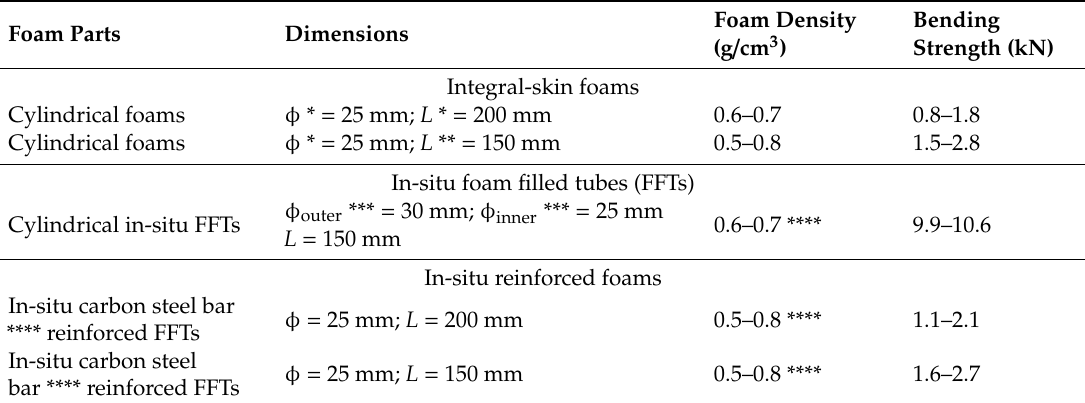
Table 3. Bending properties of the simple and composite structures made of aluminum alloy